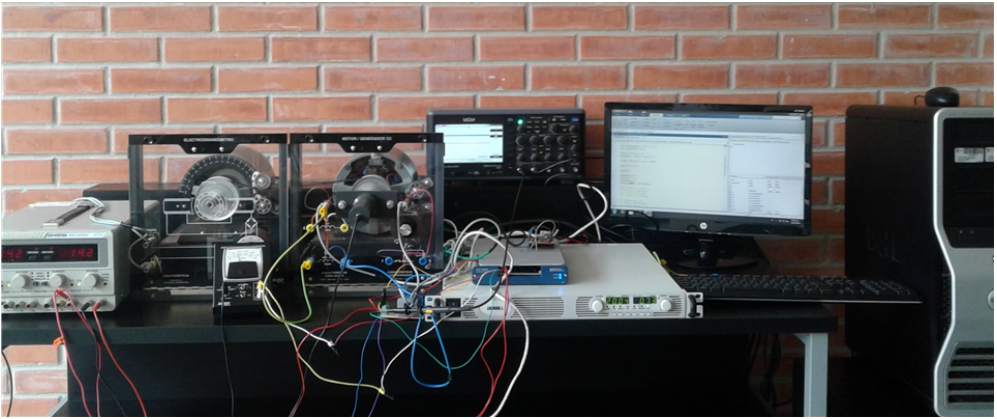
Figure 5. Experimental